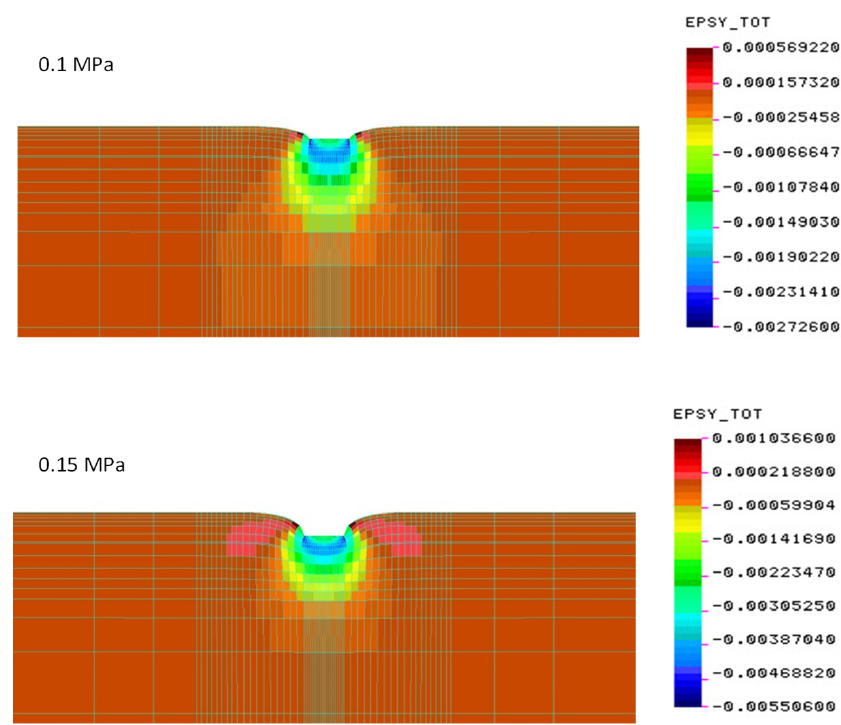
Figure 13. Vertical deformations for the native subgrade—construction No. 3 (deformation scale ×100).